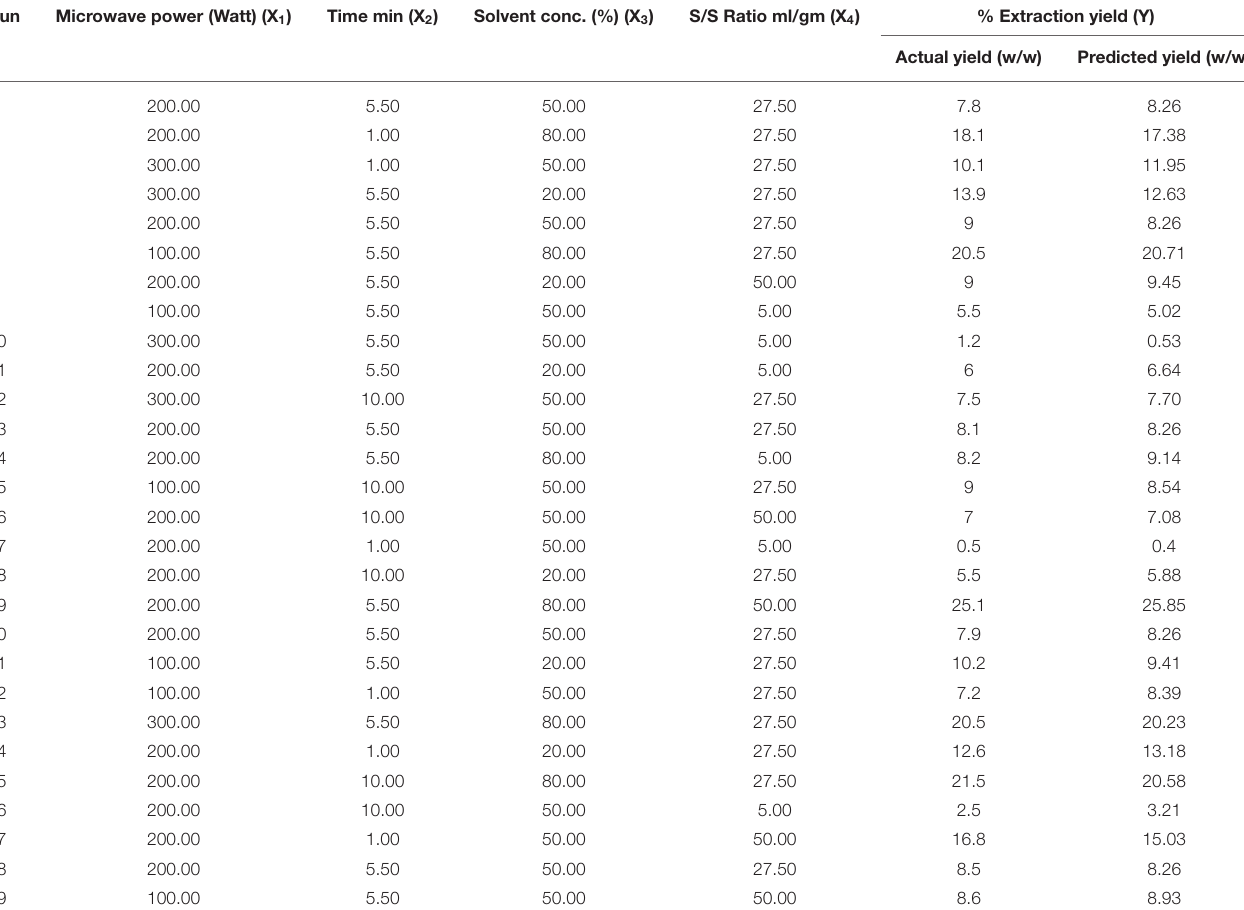
TABLE 1 | Actual and predicted EY at different extraction conditions in